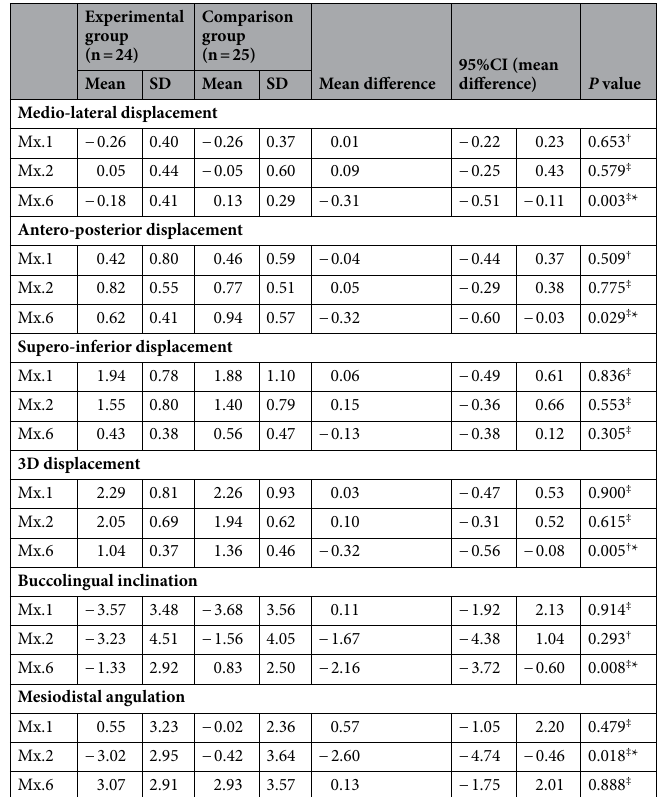
Table 3. 3D changes using the registration on the palate through regions of interest (PR). † Mann Whitney U test; ‡ t test; SD, Standard deviation; Mx.1, maxillary central incisor; Mx.2 maxillary lateral incisor; Mx.6, maxillary first molar; (−) values denote medial/posterior/superior displacements, lingual inclination and distal angulation; (+) values denote lateral/anterior/inferior displacements, buccal inclination and mesial angulation. *Statistically significant at P <